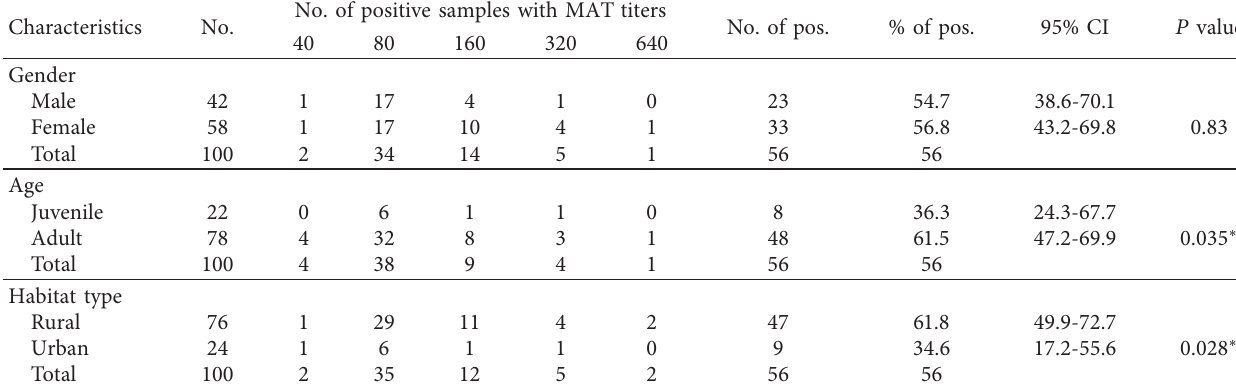
Table 1: Statistical analysis of T. gondii seropositivity in wild rats in Northern Iran based on gender, age, and habitat type. No. of positive samples with MAT titers Characteristics No. No. of